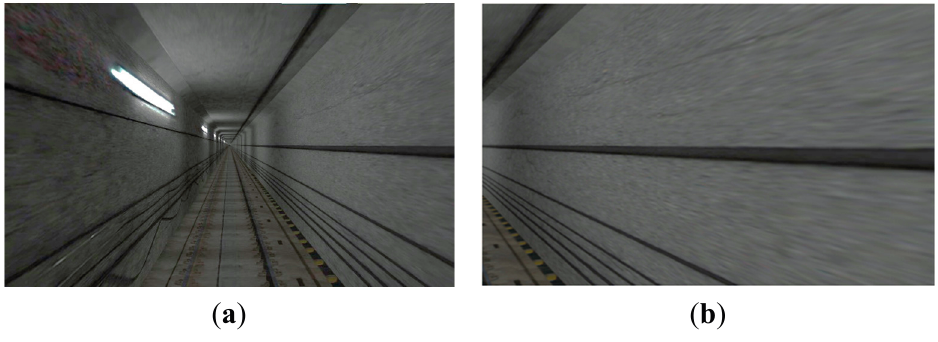
Figure 3. Examples of visual simulation scene: ( a ) Front view; ( b ) Side